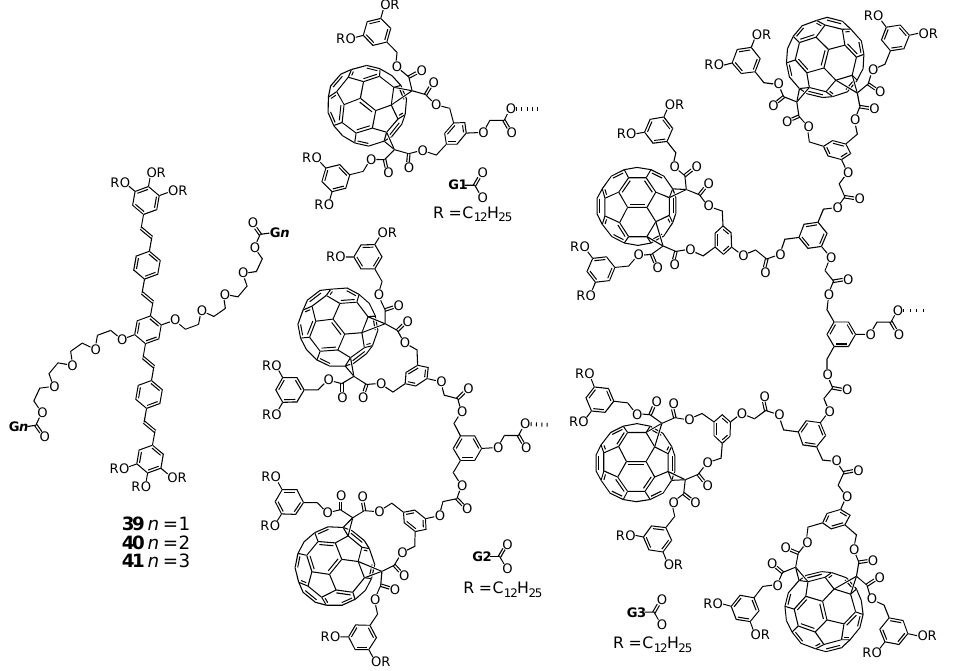
Figure 4. Structures of oligophenylenevinylene (OPV)-centred fullerodendrimers 39 - 41 .